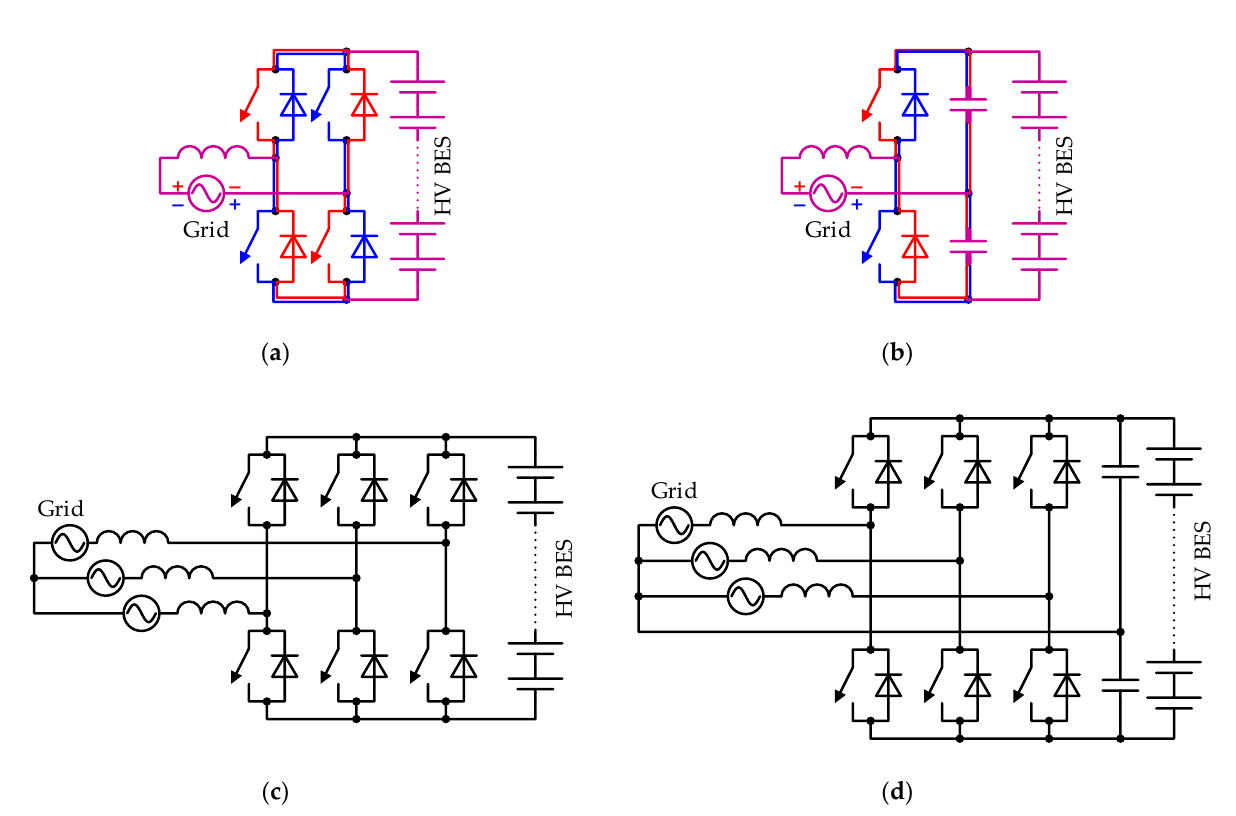
Figure 10. Configurations of single-stage bridge rectifiers-inverters for BESs: ( a ) AC current sourced transistor bridge, ( b ) AC current sourced transistor/capacitor bridge (half-bridge), ( c , d ) three-phase schemes.